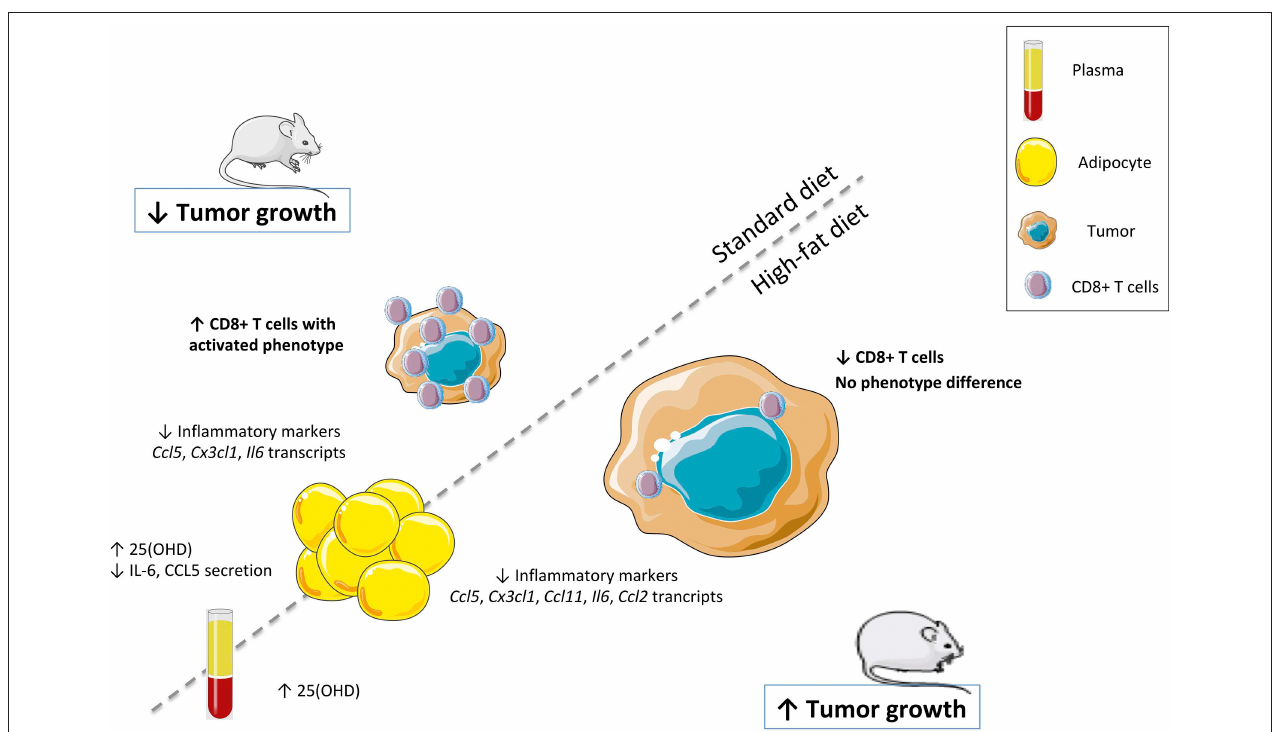
FIGURE 6 | Vitamin D controls breast cancer tumor growth and CD8 + T cells infiltrating the tumor. VD supplementation was validated in both models by the quantification of the 25(OH)D levels and inflammatory cytokines (IL-6 and CCL5) in plasma and mRNA levels of inflammatory markers ( Il6 , Ccl5 , Ccl2 , Ccl11, and Cx3cl1 ) in adipocytes. Tumor size was measured and CD8 + T cells were quantified in the